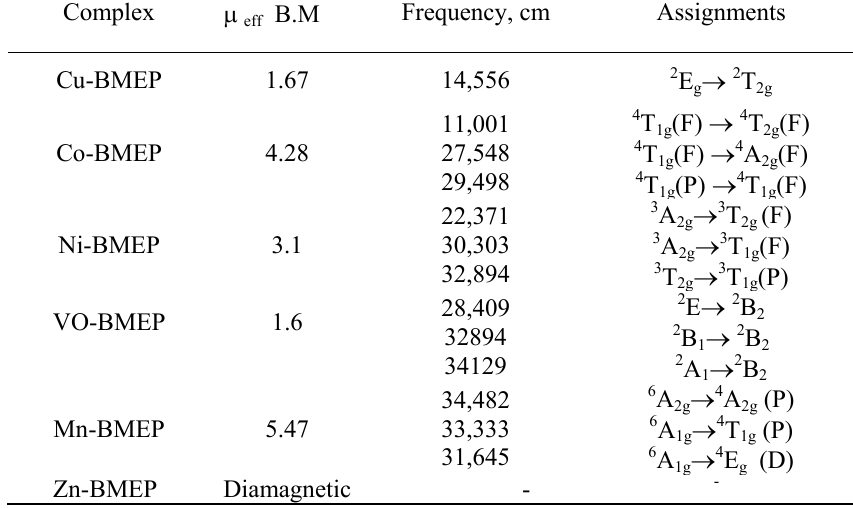
Table 3. Magnetic moments & electronic spectral data for the complexes.